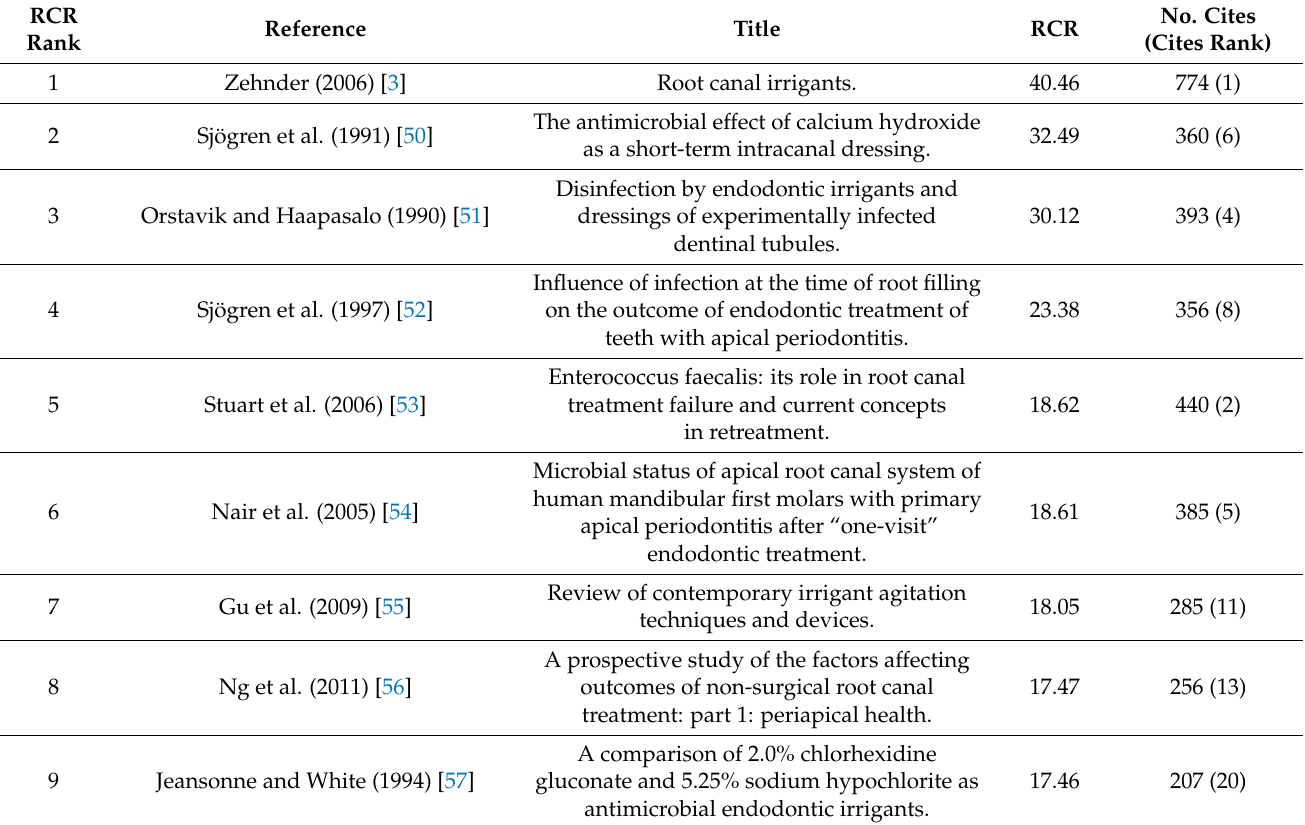
Table 1. The 20 most influential root canal disinfection articles ranked according to the highest relative citation rates. 1990–2019.